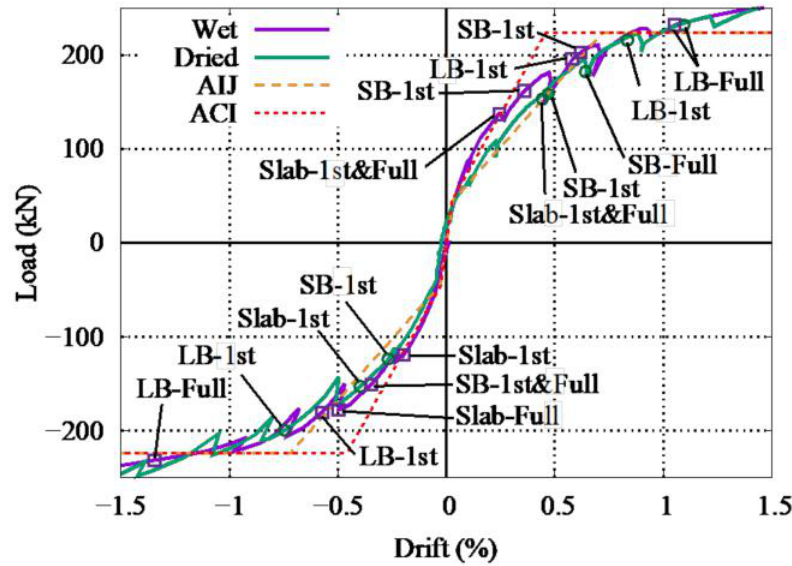
Figure 11. Comparison of the skeleton curves for the experimental and estimated